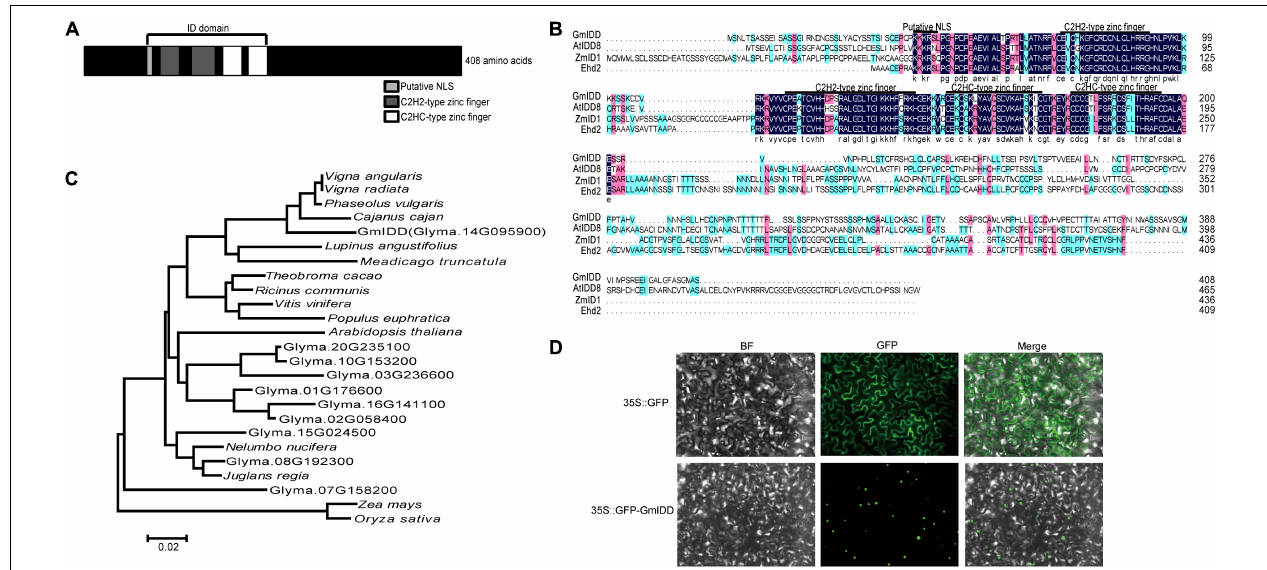
FIGURE 1 | Sequence analysis and subcellular localization of GmIDD. (A) Predicted domains of GmIDD paralogs known from Phytozome which contain a nuclear localization signal motif (KKKR) and four zinc finger domains including two types of C2H2 (72–92, 114–142 aa) and two types of C2HC (149–169, 176–195 aa). (B) Multiple alignments of the amino acid sequences encoded by GmIDD and known IDD family members in Arabidopsis , maize, and rice. The nuclear localization signal motif (KKKR) and four zinc finger domains were indicated by the line on the top. Blue, homology 100%; pink, homology ≥ 75%; light blue, homology ≥ 50%. (C) Phylogenetic tree analysis was performed on GmIDD and proteins from other species with high similarity in NCBI. All the amino acid sequence information comes from the Phytozome database (accession numbers are listed in Supplementary Table S2 ). A phylogenetic tree containing 10 soybean proteins with complete ID domain and 15 IDD proteins from other species ( Theobroma cacao , Ricinus communis , Vitis vinifera , Populus euphratica , Arabidopsis thaliana , Nelumbo nucifera , Juglans regia , Lupinus angustifolius , Cajanus cajan , Phaseolus vulgaris , Vigna angularis , Vigna radiata , Zea mays , Medicago truncatula, and Oryza sativa . Phylogenetic tree was constructed using the neighbor joining method of MEGA 6.0. (D) Subcellular localization of GmIDD protein. The 35S:GFP-GmIDD fusion expression vector was used for agroinfection in N.benthamiana . The tobacco leaves infected with 35S:GFP agrobacterium were used as control. After infiltration, the tobacco leaves were grown for 2 days and the GFP signal was detected by fluorescence microscopy. GFP, Green Fluorescent Protein; BF, bright field; Merge, GFP, and bright-field